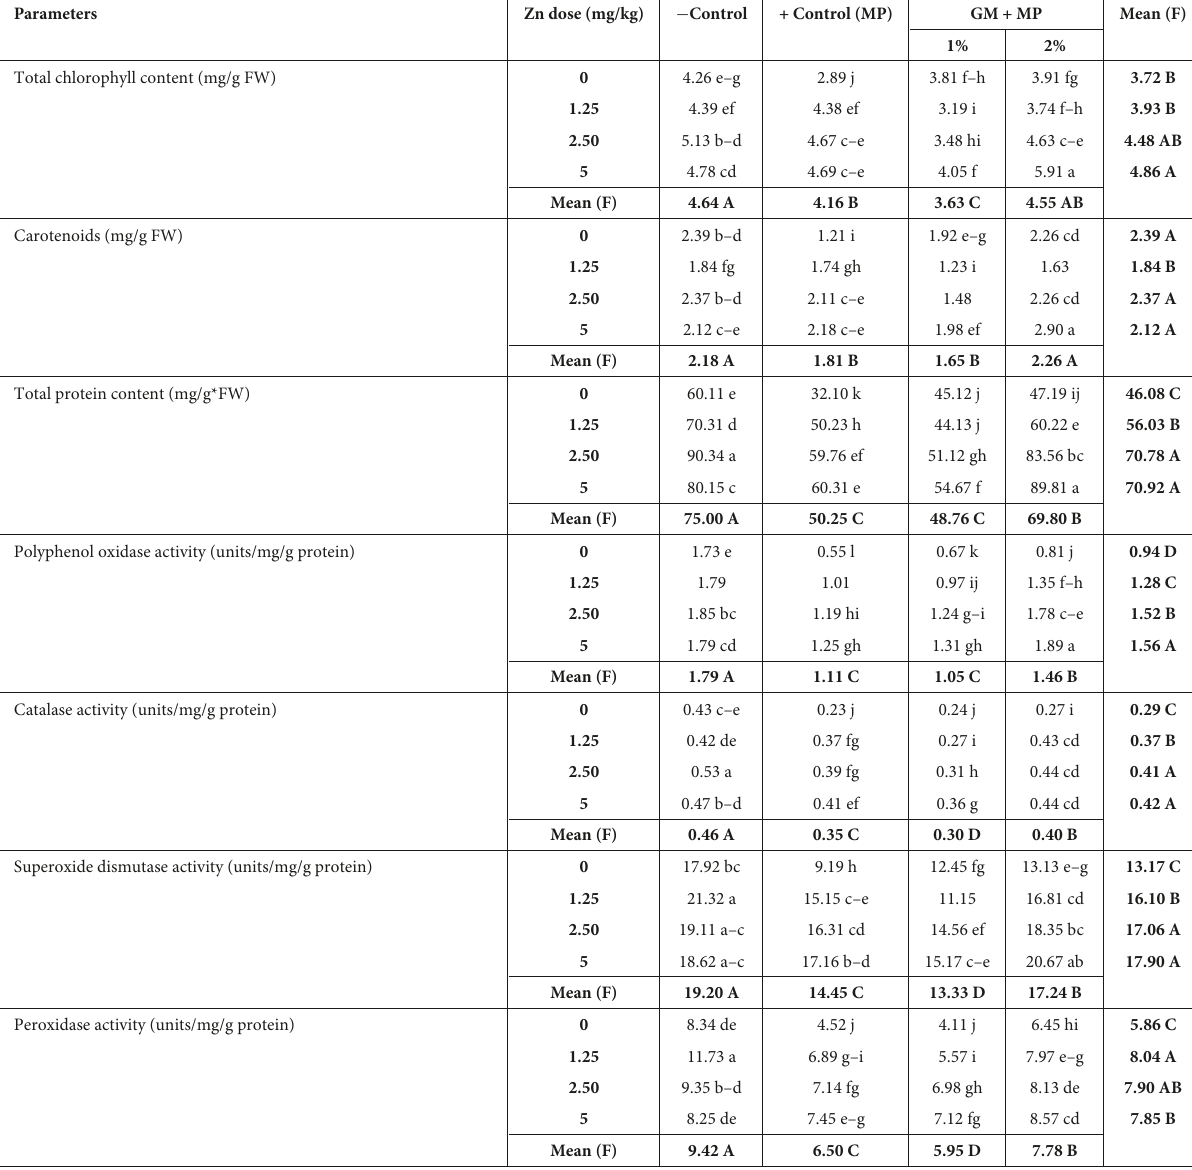
TABLE 3 Zinc (Zn) and green manure (GM) impact on physiological attributes in highly susceptible (MNUYT-105) genotypes of mungbean inoculated with Macrophomina phaseolina (MP). Parameters